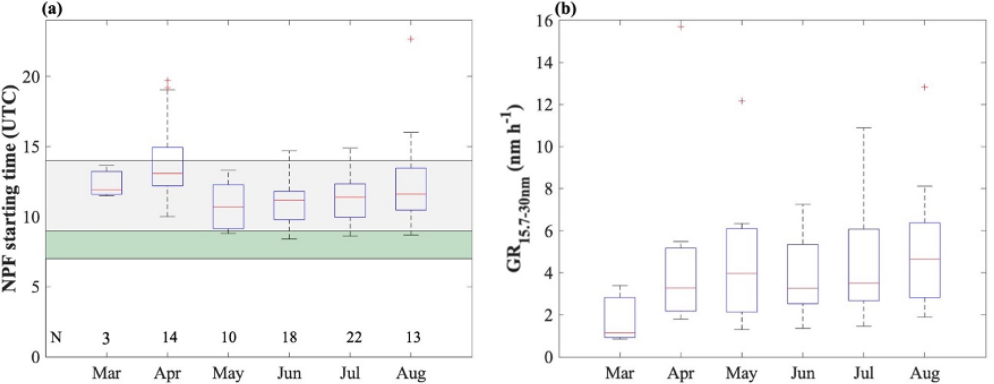
Figure 4. Monthly variation of NPF events (a) starting time and (b) their growth rate (GR 15 . 7–30nm ) at the ATOLL station during 2017– 2020. The boxes and whiskers (bottom to top) represent the 10th and 25th percentiles, median (red line), and the 75th and 90th percentiles. Crosses represent the outliers. The grey area represents the period, from 09:00–14:00UTC, when most of the NPF events occur. The blue area corresponds to the period before the NPF onset (07:00–09:00UTC). N represents the number of events observed per month.